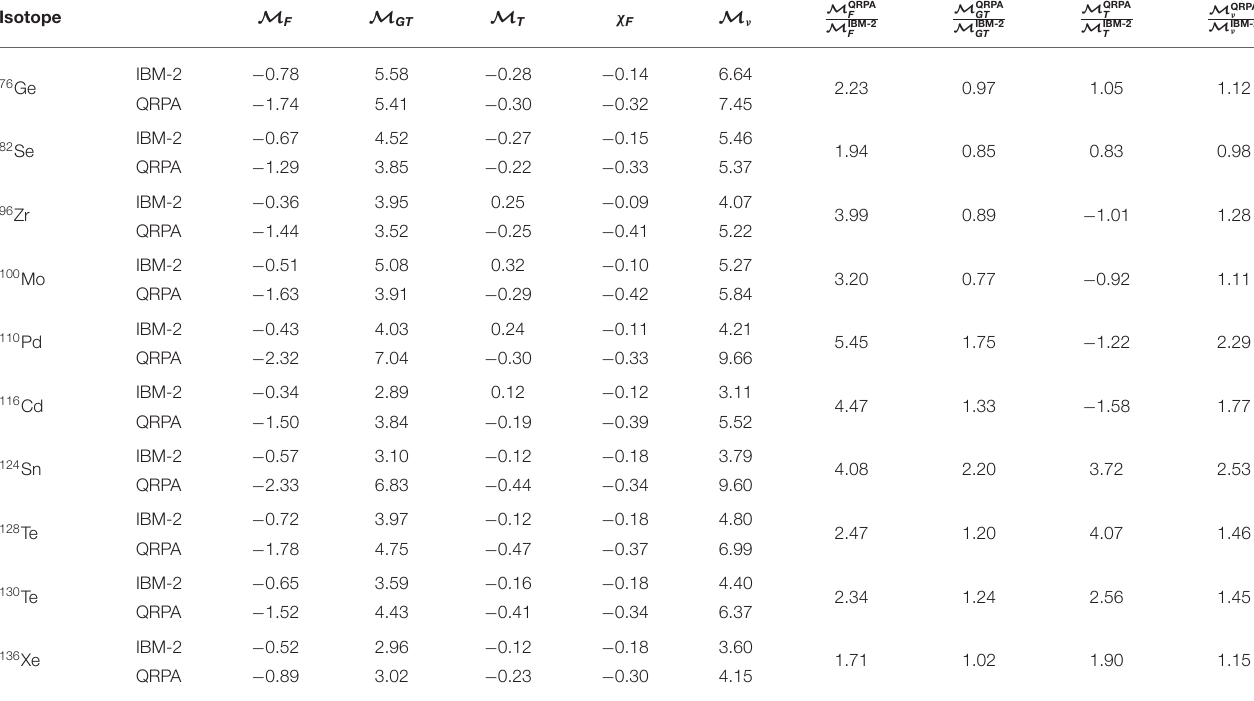
TABLE 3 | Comparison between interacting boson model (IBM-2) and quasiparticle random phase approximation (QRPA) light neutrino exchange Fermi (F), Gamow–Teller (GT), tensor (T), and full M ν NMEs as defined in Equations (12) and (13) calculated using quenched value g A = 1.0.